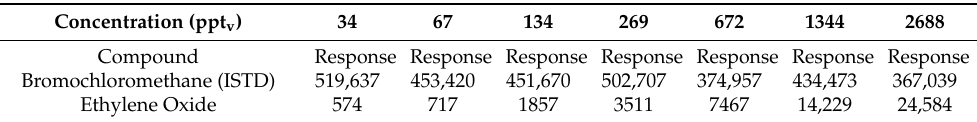
Table 5. Internal standard and EtO calibration